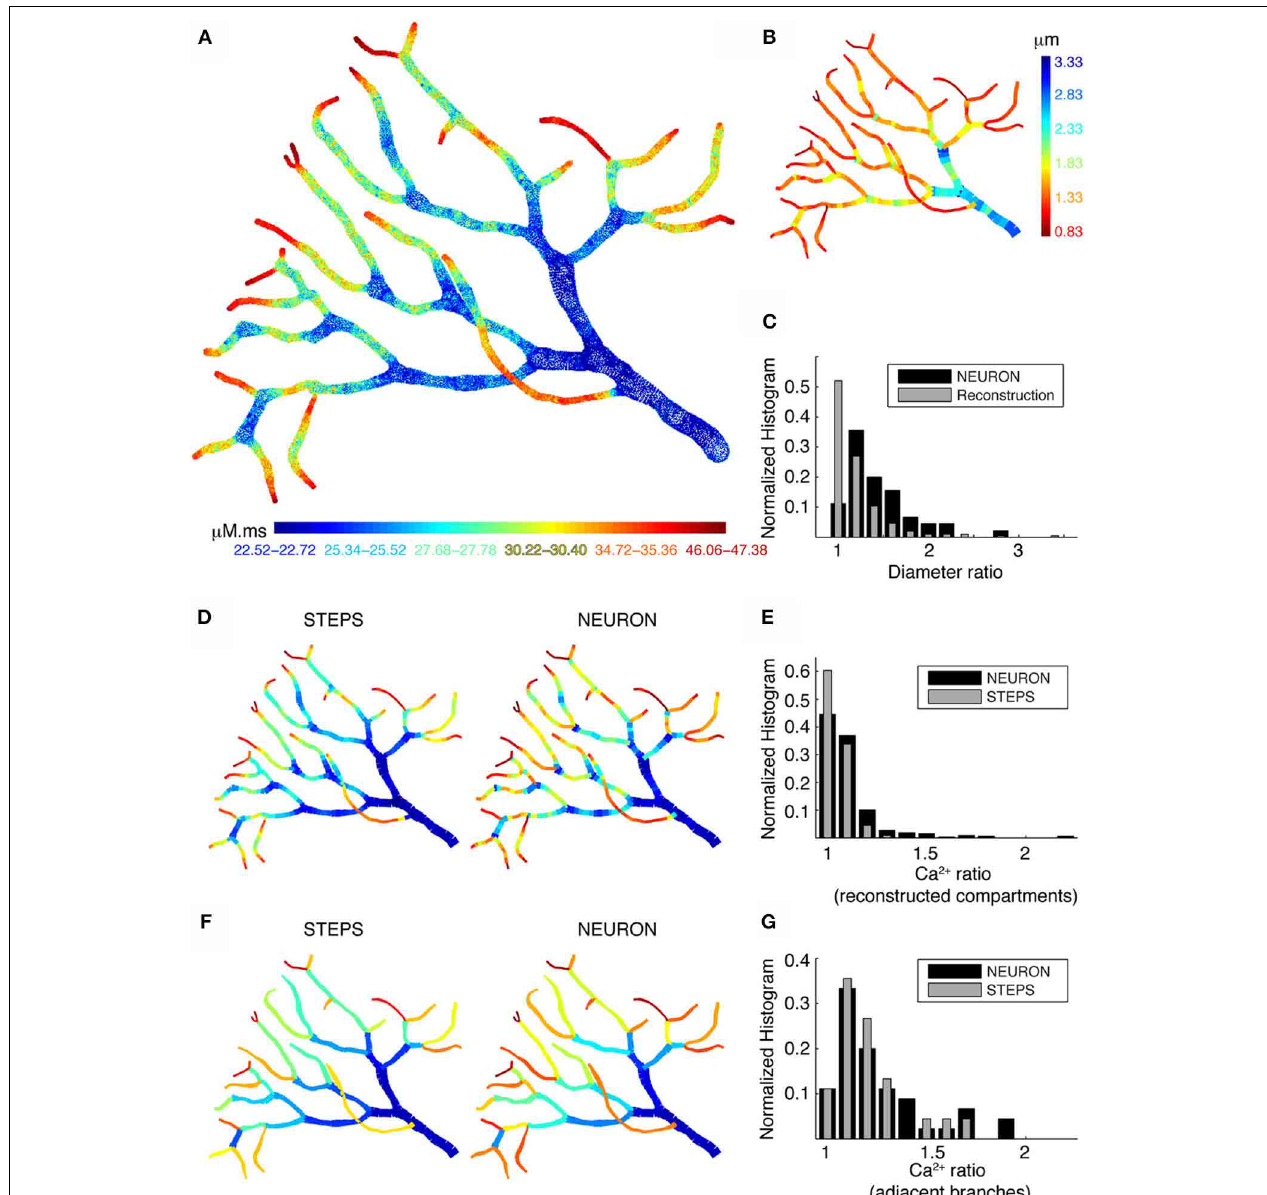
FIGURE 8 | Large differences in calcium levels in adjacent dendritic branches persist in presence of 3D diffusion. (A) STEPS model using 3D buffered diffusion to compute the Ca 2 + concentration resulting from the burst of Ca 2 + spikes. Spatial map of integrated calcium (140ms window) in a piece of carefully reconstructed PC dendritic arbor (part of PC 1). Every colored dot drawn at the center coordinates of each tetrahedron belonging to the mesh in which 3D diffusion was simulated shows the integrated Ca 2 + in that particular tetrahedron. Only tetrahedrons representing the submembrane region are plotted. The color scales used in these maps are nonlinear (using histogram equalization) to enhance the contrast. (B) Spatial map of dendritic diameters in the dendrite shown in (A,D,F) . (C) Normalized histograms compare the ratios of adjacent diameters in the original morphological reconstruction with similar ratios of diameters of adjacent compartments in the NEURON model (1 segment